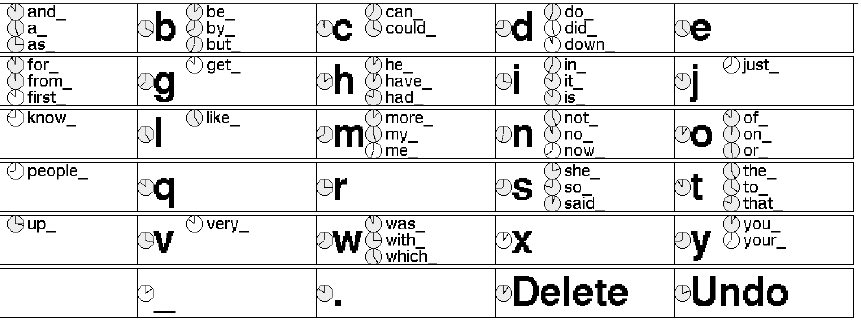
Figure 2. The Nomon Keyboard, a writing application (screenshot). Words that are prefixed by the concatenation of the current context and the letter X appear next to the letter X. Underscore represents a space. Options for period, a character-deletion function, and an undo function are also available.